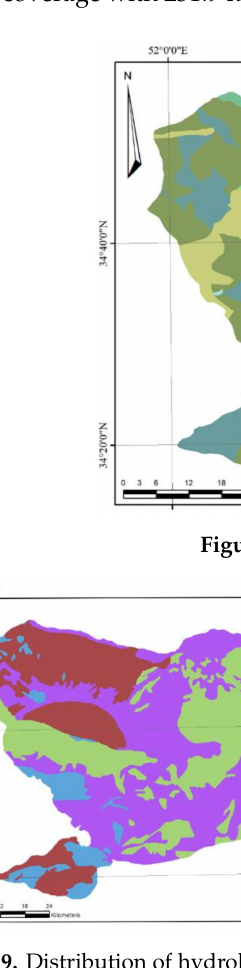
Figure 9. Distribution of hydrological soil group map (A) and curve numbers (B) in the study